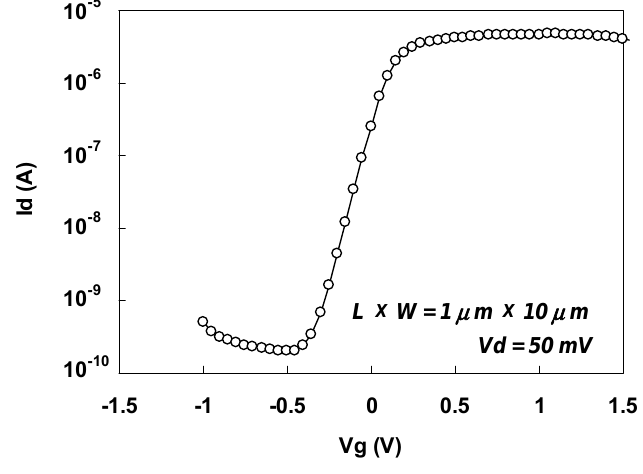
Figure 44. Id-Vg characteristics for an n-MOSFET annealed for 1 min at 450 °C after sulfur